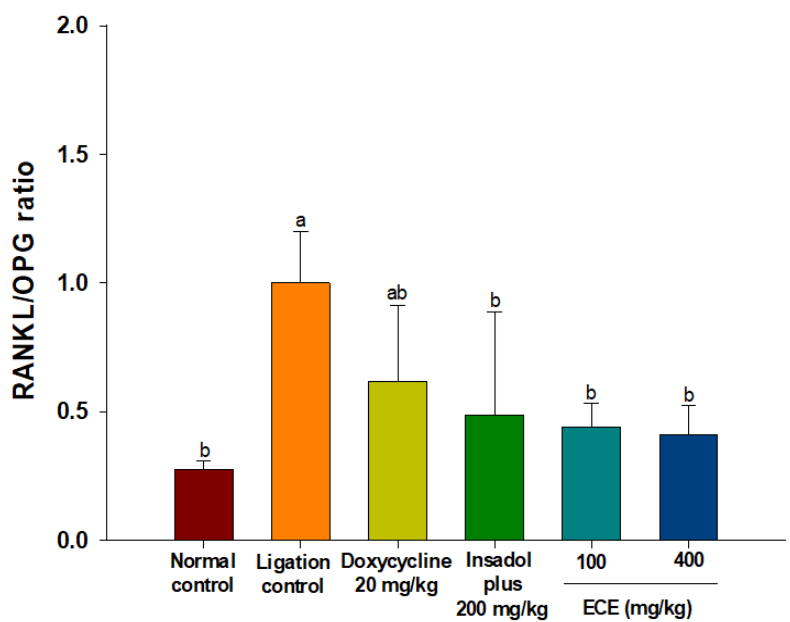
Figure 6. Effect of ECE on RANKL/OPG expression ratio in periodontitis rats. Bars with different letters indicate significant differences (n = 6, p < 0.05). ECE: Ecklonia cava extract; RANKL: receptor activator of nuclear factor kappa-B ligand; OPG: osteoprotegerin.